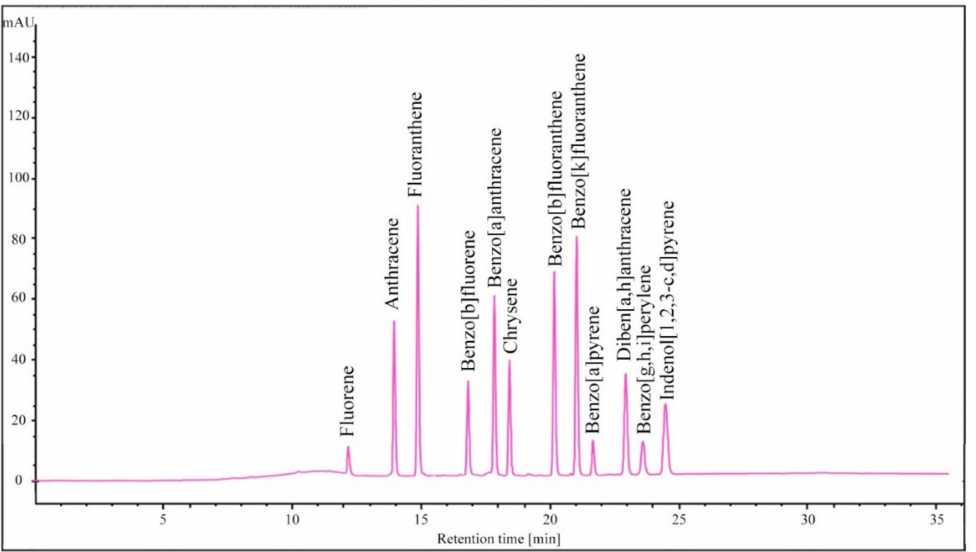
Figure 1. Chromatogram of the corresponding 12 PAH standards: fluorene, anthracene, fluoran- thene, benzo[b]fluorene, benz[a]anthracene, chrysene, benzo[b]fluoranthene, benzo[k]fluoranthene, benza[a]pyrene, diben[a,h]anthracene, benzo[g,h,i]perylene and